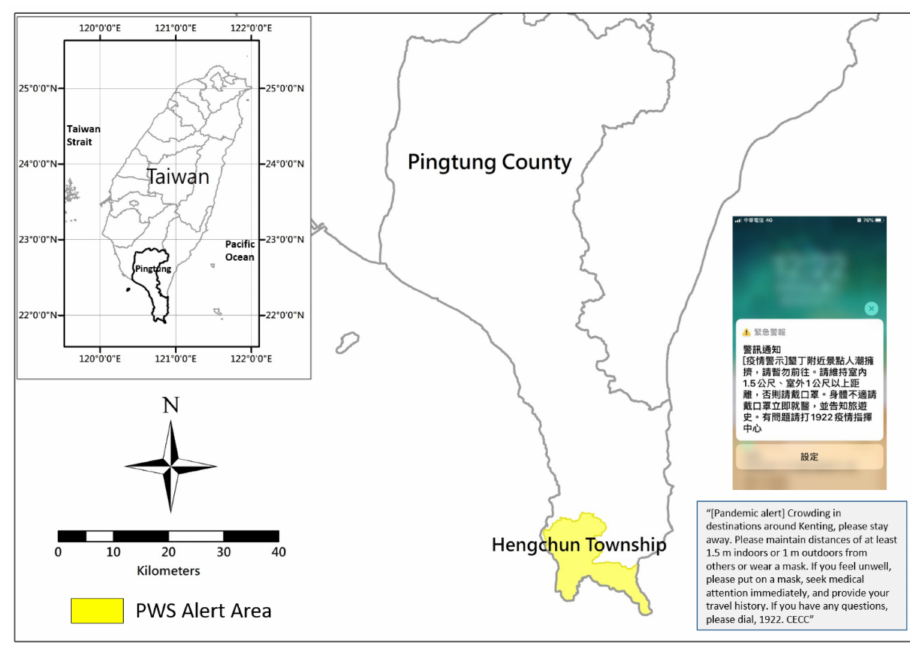
Figure 8. PWS message sent on 4 April by the CECC.